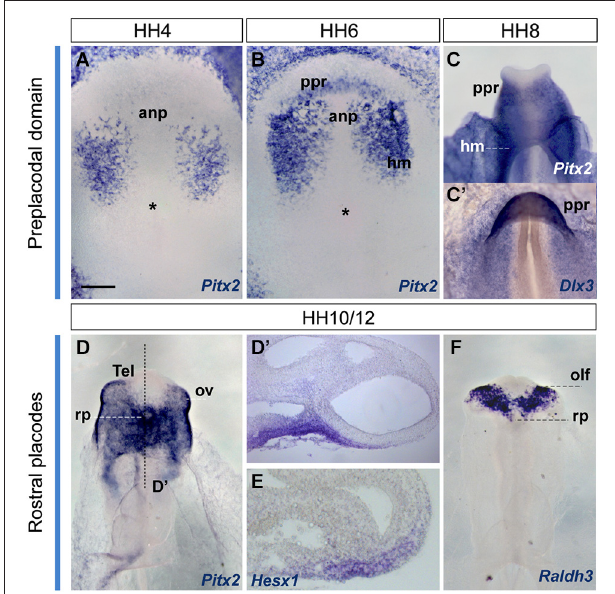
FIGURE 5 | Early gene expression at the ADH primordium . Neural plate and neural tube whole mounts hybridized with Pitx2 , Dlx3 , Hesx1 and Raldh3 . The images are shown in a ventral view. The node is marked by an asterisk in some of the images. Scale bar: 250 µ